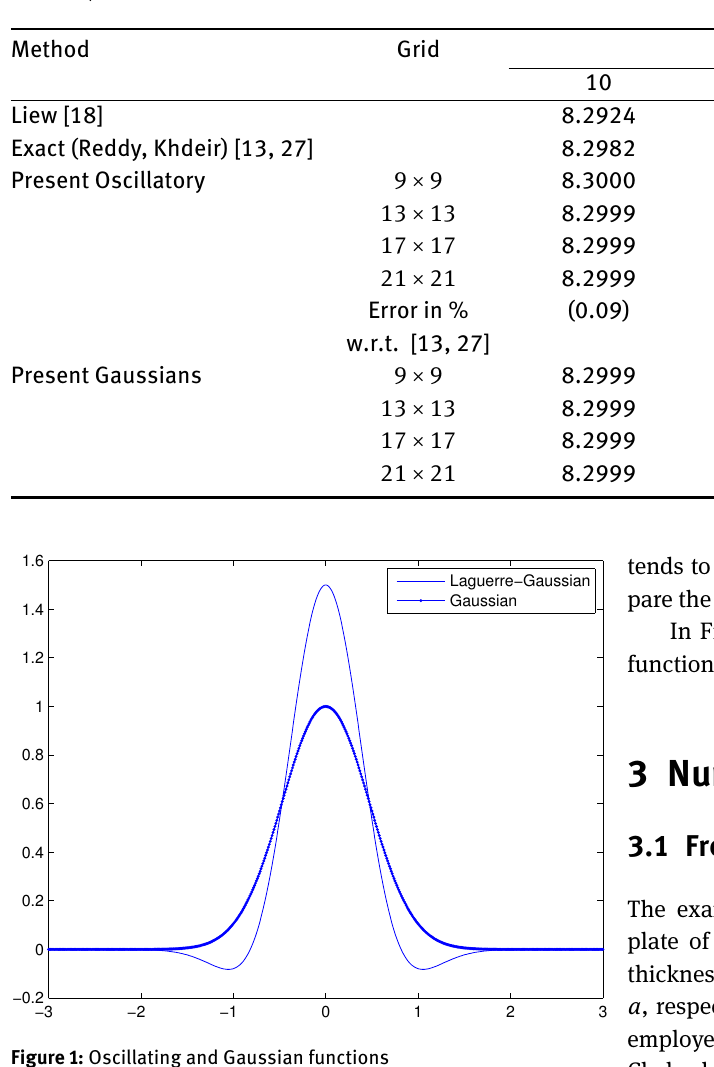
Table 1: The normalized fundamental frequency of the simply-supported cross-ply laminated square plate [0 ∘ /90 ∘ /90 ∘ /0 ∘ ] (¯ w = ( wa 2 / h ) √︀ ρ / E 2 , h / a = 0.2)